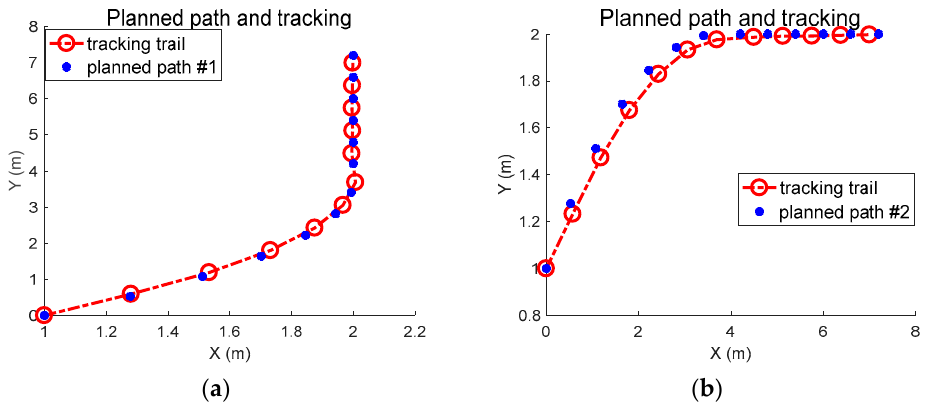
Figure 4. Path tracking results based on the pose deviation model. ( a ) The differences between the planned positions along path #1 and the real positions during tracking; ( b ) The differences between the planned positions along path #2 and the real positions during tracking.